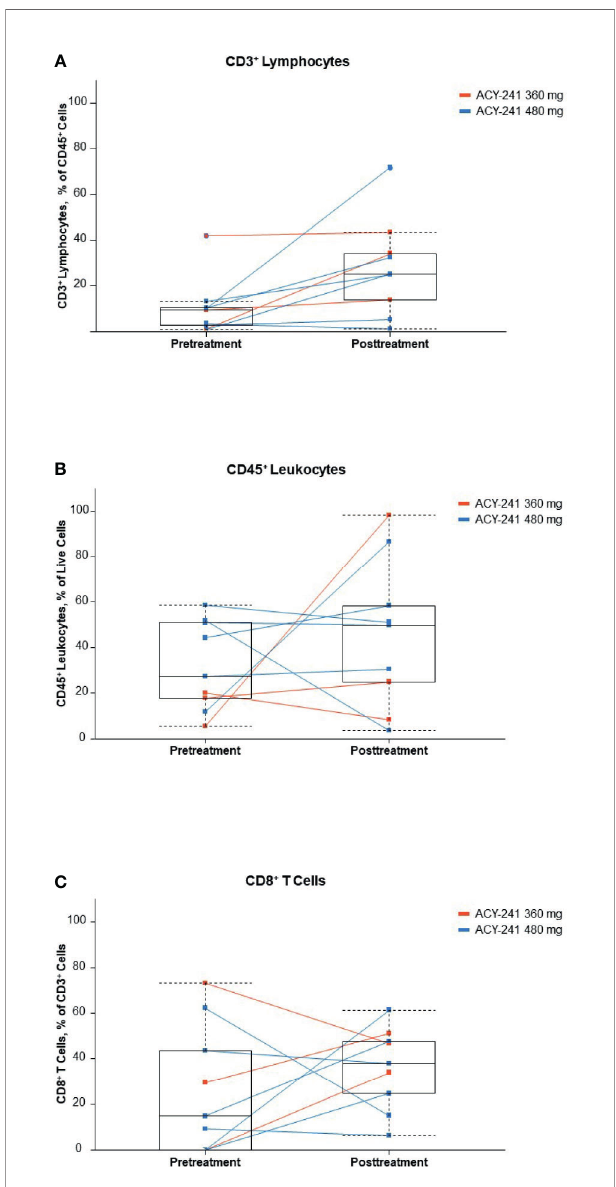
FIGURE 3 | In fi ltrating immune cells (A) , CD3 + lymphocytes; (B) , CD45 + leukocytes; (C) , CD8 + T cells. Percentages of selected immune cell subpopulations in tumor biopsies before and after ACY-241 treatment. These patients originated in 2 dose-level cohorts, which are indicated by different colors (orange, 360 mg; blue, 480 mg). To facilitate the determination of trends, a light-blue box plot (median, second, and third quartiles, and min- max range) is overlaid on the line